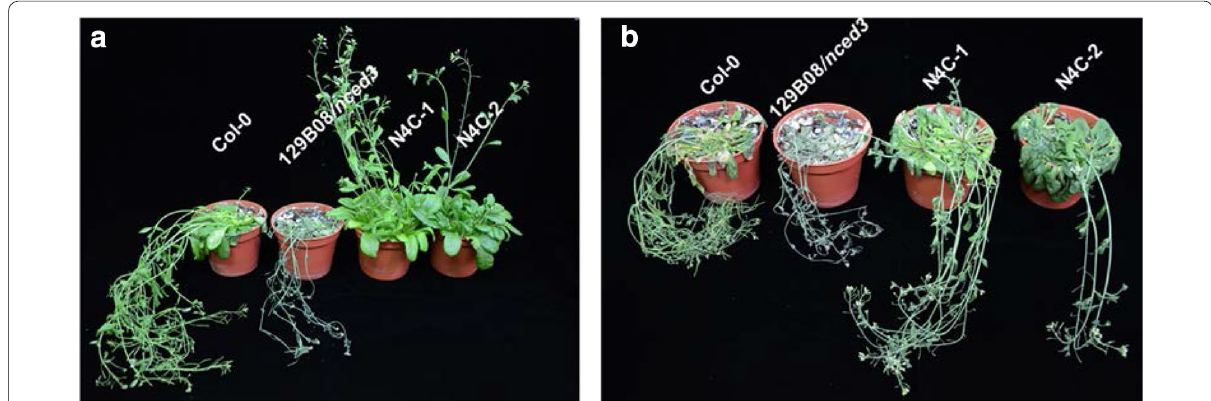
Fig. 7 Overexpression of OsNCED4 in transgenic Arabidopsis plants conferred drought tolerance. a Col‑0, 129B08/ nced3 mutant, and two N4C transgenic lines after 9 days of withholding water. b Col‑0, 129B08/ nced3 mutant, and two N4C transgenic lines after 13 days of withholding